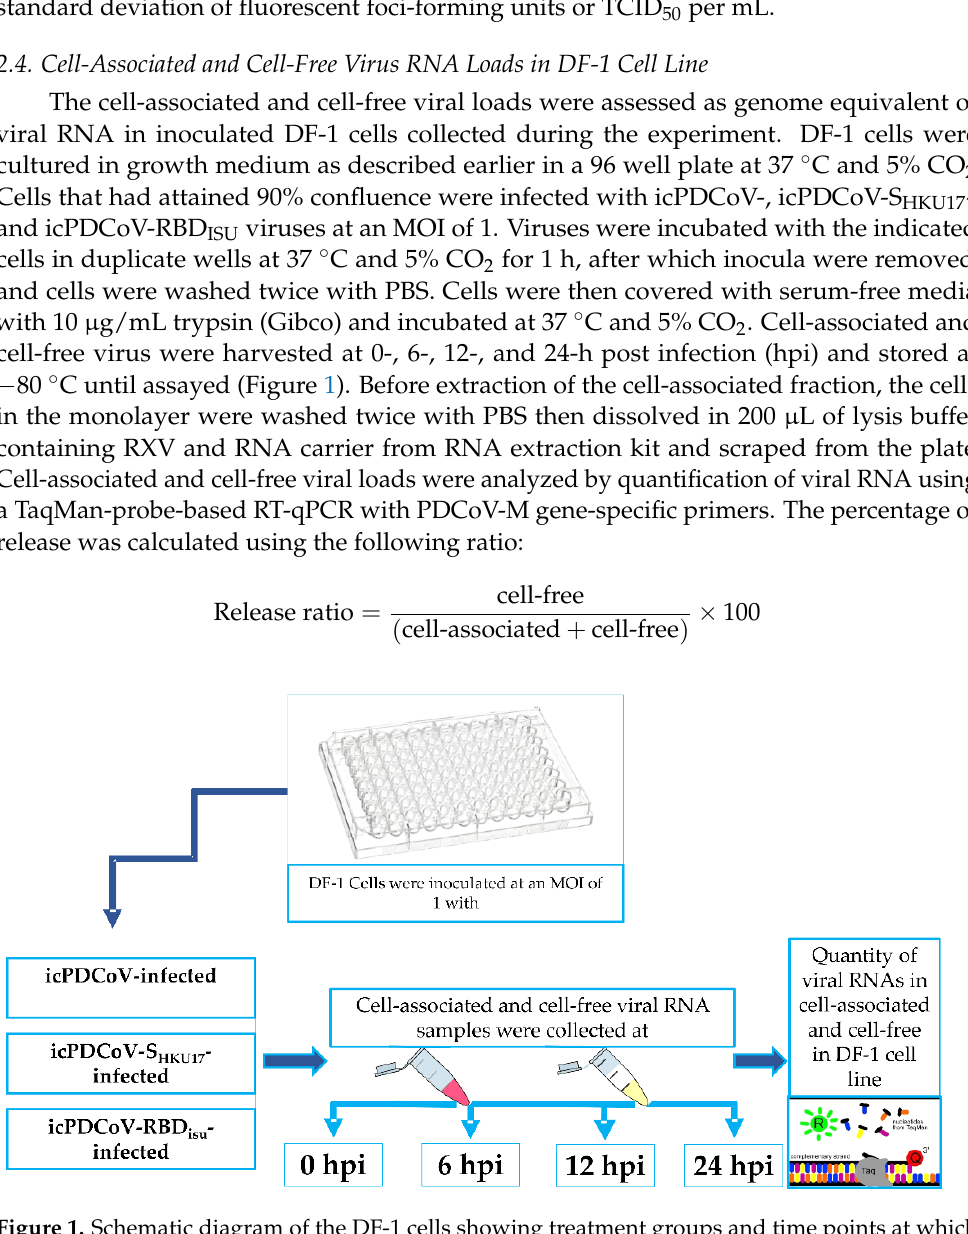
Figure 1. Schematic diagram of the DF-1 cells showing treatment groups and time points at which cell-associated and cell-free were collected for viral RNA titration.